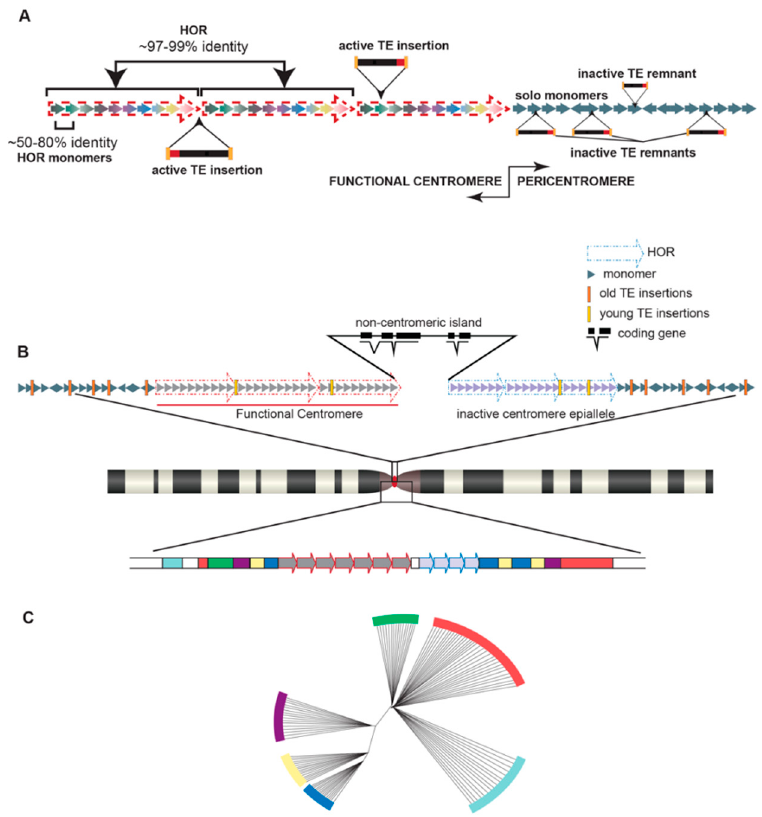
Figure 1. Overview of satellite DNA structure in a human centromere/pericentromere. ( a ) α satellite monomers (colored solid arrows) are organized into a repeating unit, called a higher order repeat (HOR) (red dashed arrows). In this example, 10 monomers are in each HOR (10-mers). HOR units are repeated in a chromosome-specific manner 100–1000 s of times within a functional centromere core. Within a single HOR, monomers share anywhere from 50–80% sequence identity with one another. The same monomer within different HORs in the same array may share up to 99% identity. Solo monomers (solid arrows) are found in the pericentromeric region and are highly variable in terms of sequence and orientation. Within the centromere, transposable elements (TE) insertions typically include recently active or active (hot) elements, while the TE insertions found in the pericentromere are older, inactive elements. ( b ) The core centromere structure (red dot, chromosome schematic) of human chromosomes (a generic chromosome ideogram is indicated, middle) consists of different α satellite arrays arranged in HORs (dashed arrows). Each HOR array may contain a different monomer number; in this example, the functional centromere (i.e., assembles CENP-A nucleosomes) at a 10-mer HOR (red dashed arrows). A 7-mer HOR is found nearby but is an inactive epiallele. Both HORs are separated by non-centromeric DNA, which may contain genes. α satellites are also found throughout the pericentromere (bottom schematic, different colored blocks). ( c ) Representative cladogram of the phylogenetic relationship of the non-HOR α monomers shown in (b). In this example, strata of newer satellites are closer to the HOR arrays, while older satellites are found more distally. Relative age of satellites is indicated by tree branch length; shorter branches are younger elements and deeper branches are older.